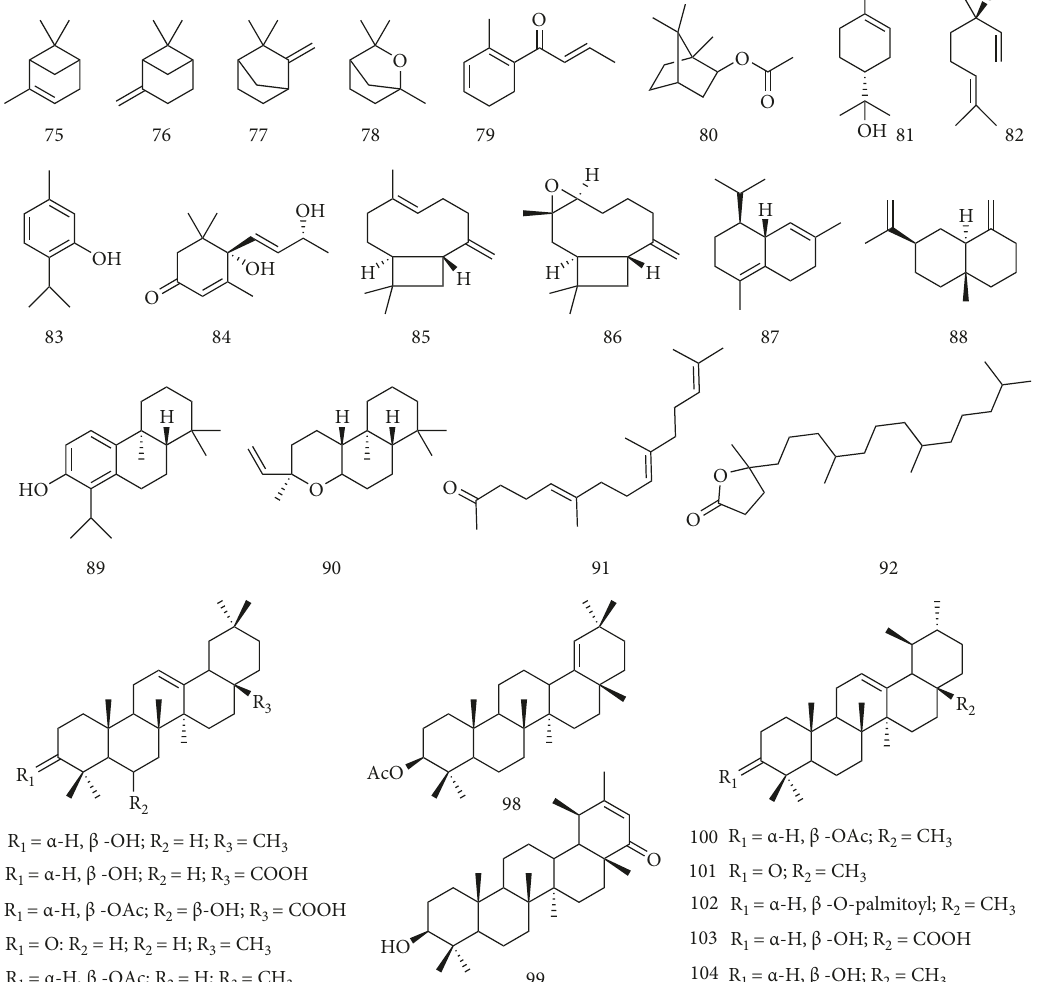
Figure 3: Structures of the terpenes and terpenoids found in F. tikoua